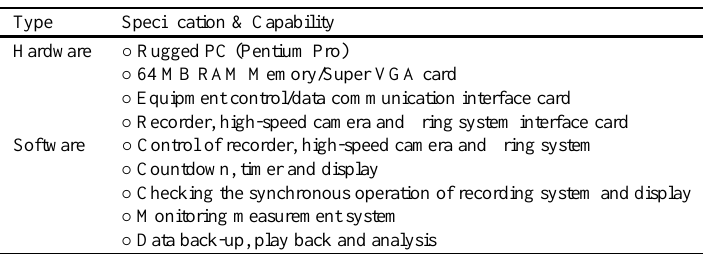
Table 2 Characteristics of controller